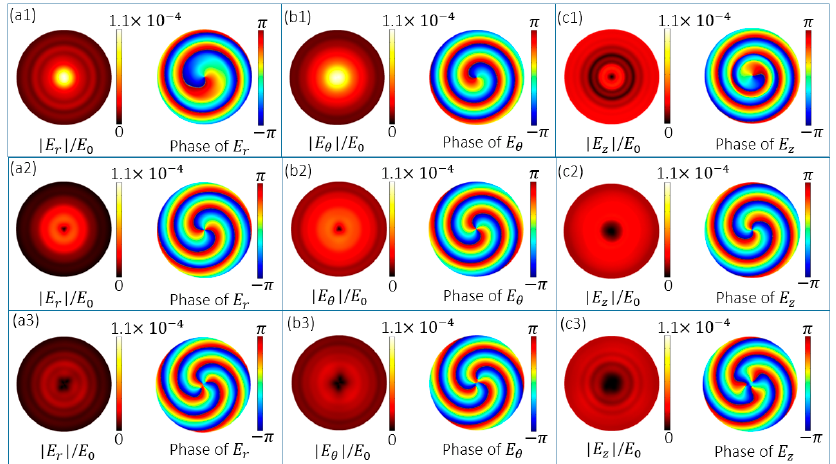
Figure 2. Tuning the OAM of the emitted light. The first row [( a1 )–( c1 )], second row [( a2 )–( c2 )], and third row [( a3 )–( c3 )] of the figure present the simulation results of the modes for q = 1, 2 and 3, respectively. These results are in the cross section (the radius of the area is 5000 nm) of the emission modes at 2 μm above the upper surface of the cavity. It is worth noting that the corresponding modes inside the cavity (mode 1) have nearly the same field intensity.